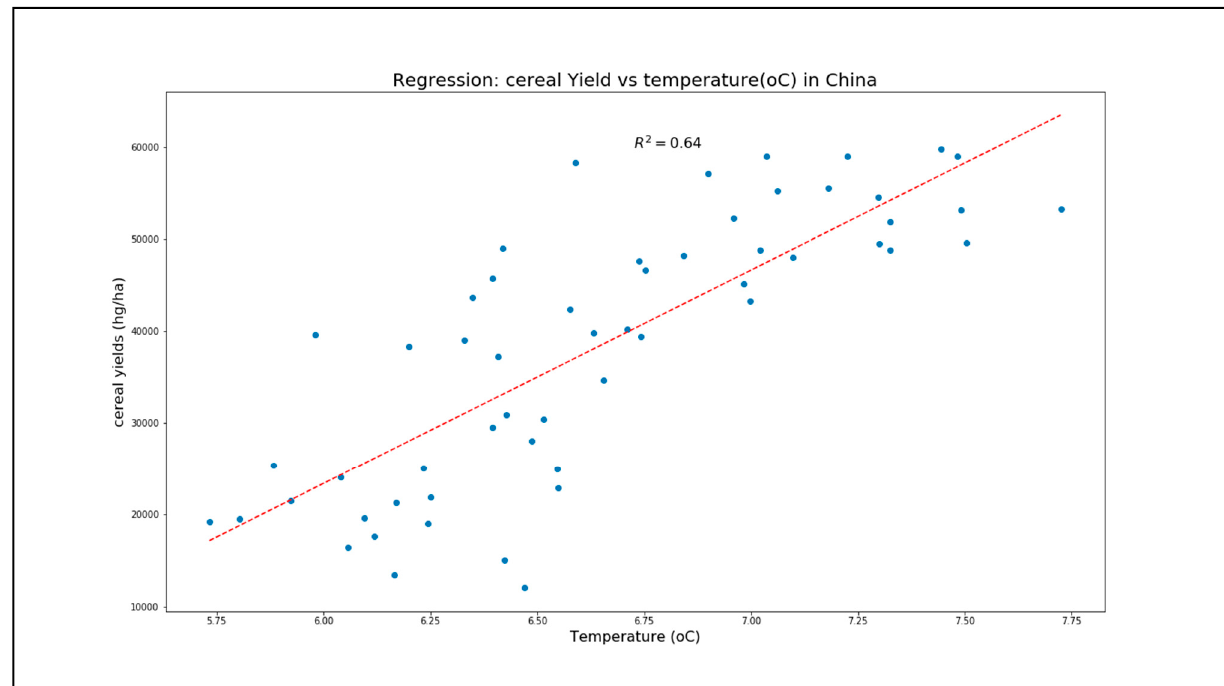
Figure 5. Crop yield—Cereal vs. temperature (in °C) in China.